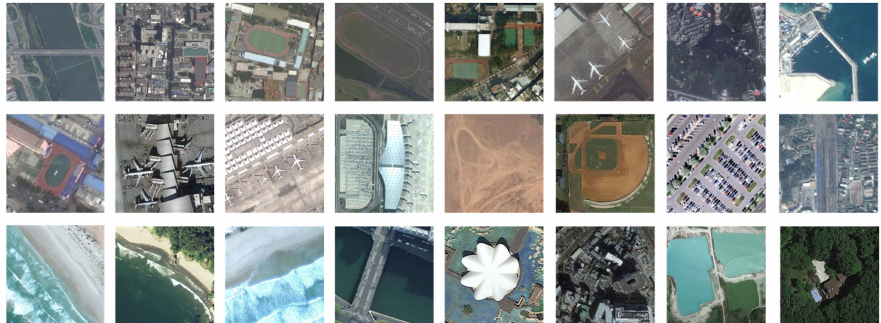
Figure 7. Schematic diagram of some remote sensing samples in the RSICD dataset. The sizes of samples provided in RSICD are all 224 × 224. Unlike the UCM-Captions dataset and Sydney-Captions dataset, the remote sensing samples in RSICD are in JPEG format. The RSICD has the richest scene categories and the largest number of samples in the three datasets. The figure shows the samples of airports, churches, coasts, farmland, ponds, deserts and other categories.